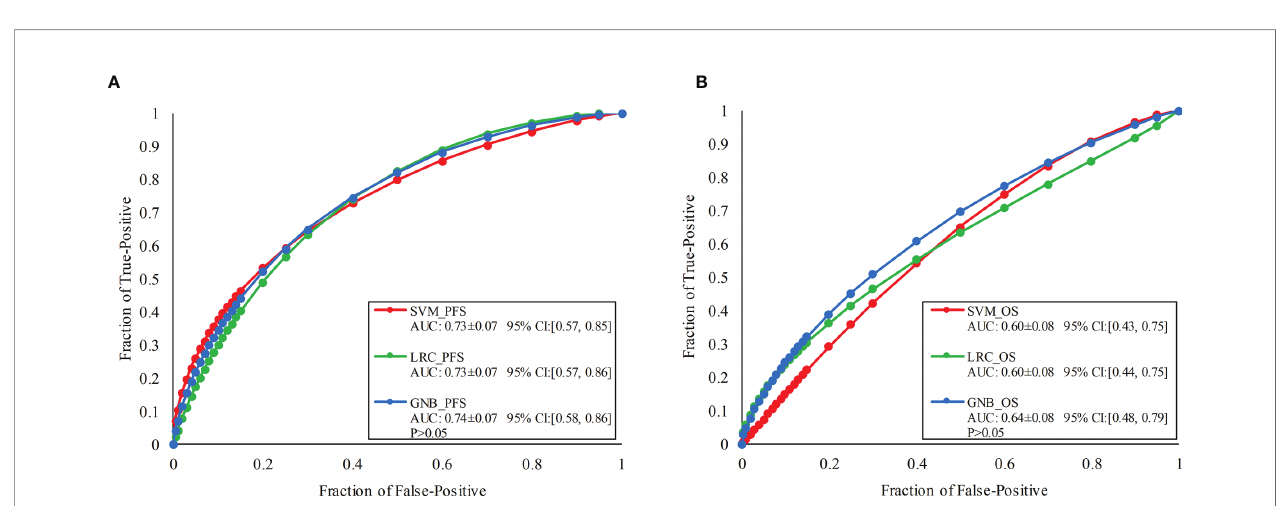
FIGURE 6 | ROC comparisons of PFS and OS classi fi cation models built with three classi fi ers namely, SVM, LRC, and GNB, respectively. (A) Illustrates the ROCs of PFS classi fi cation models, (B) illustrates the ROCs of OS prediction